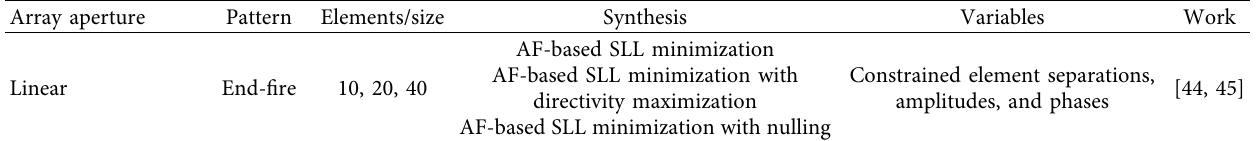
Table 4: Gradient-based optimization synthesis: selected applications and